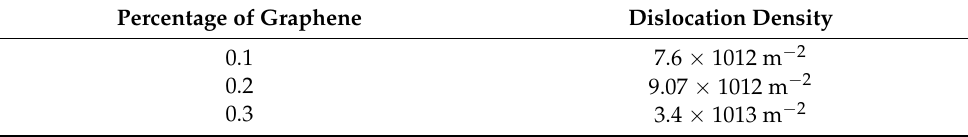
Table 5. Dislocation density.